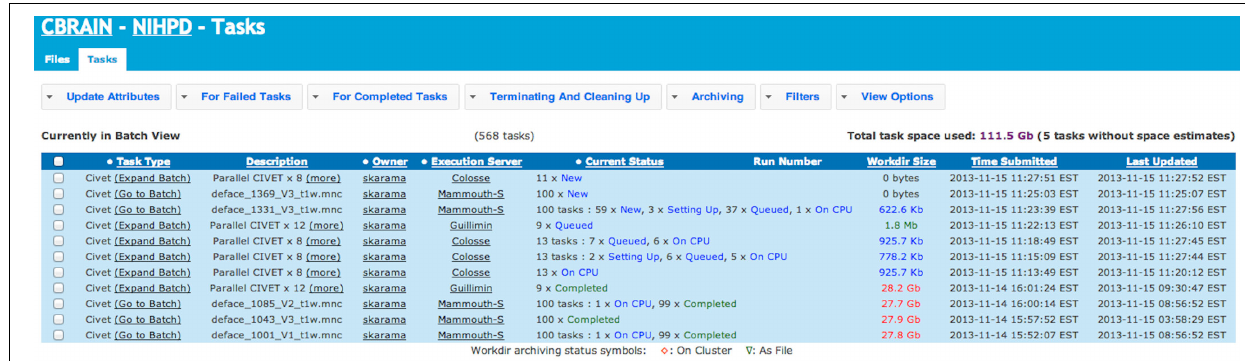
FIGURE 4 | CBRAIN portal: tasks view. The tasks view allows monitoring of taskprogress,ifdesired.Inthisexample,theCIVETpipelinehasbeenlaunched on 1082 MINC files. This workload was split in 568 tasks on 3 different computing sites. CBRAIN has automatically packaged the jobs in proper task units for each execution server. Colosse provides full node scheduling with 8